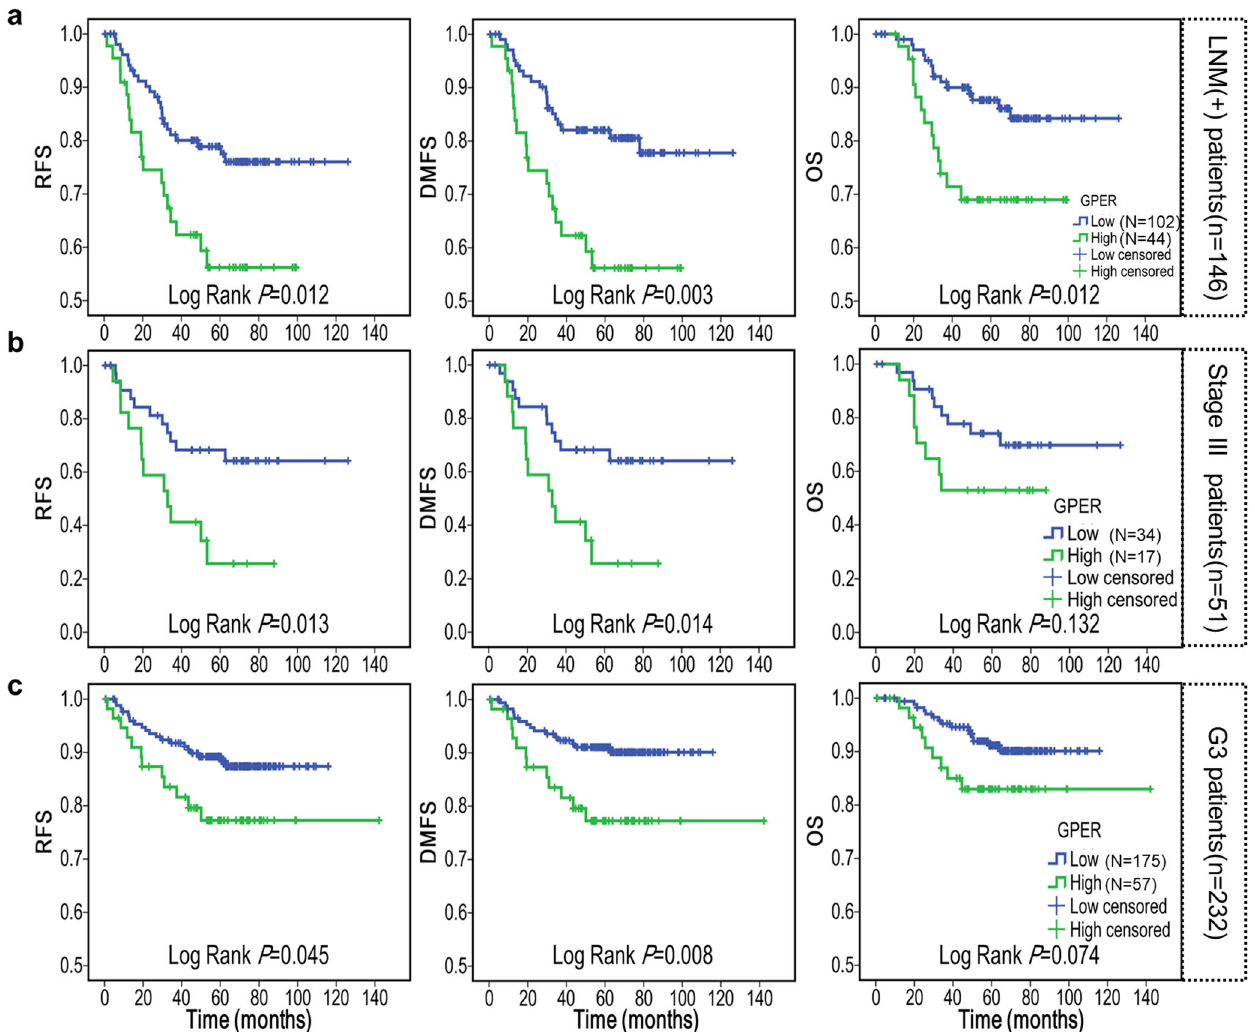
Fig. 4 Kaplan – Meier curves between GPER-low and GPER-high groups in high-risk patients. a Kaplan – Meier curves of RFS, DMFS and OS in LNM ( + ) patients. b Kaplan – Meier curves of RFS, DMFS and OS in stage III patients. c Kaplan – Meier curves of RFS, DMFS and OS in patients with G3 tumors. Statistically signi fi cant differences were de fi ned as P <